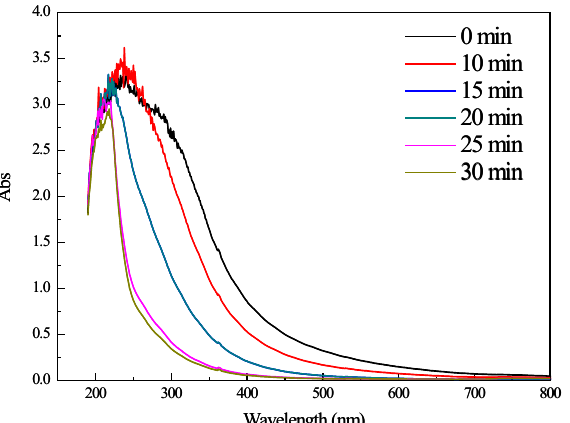
Figure 11. UV–Vis analysis at different catalytic ozonation times with pH of 9, initial COD of 121.5 mg/L, catalyst dosage of 30 g/L and ozone dosage of 3 g/h.